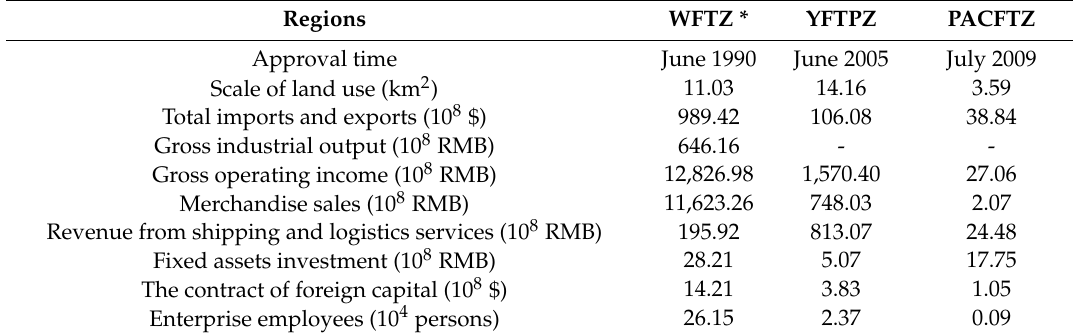
Table 1. Overview of China (Shanghai) free trade zone (2013).